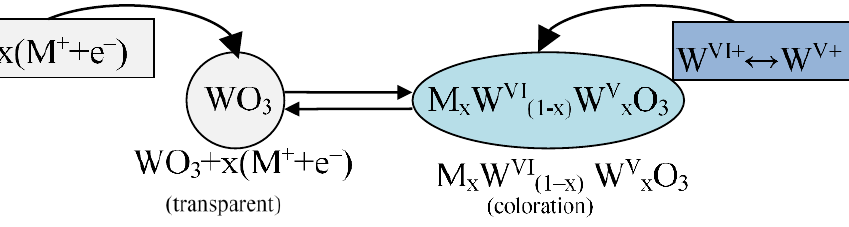
Figure 16. Electrochromic mechanism of WO 3 film. WO 3 films have different colors depending on x. At low values of x, the film is colored blue, and at high values of x, it has either a red or golden tint. These phenomena are associated with the fact that, firstly, WO 3 is partially reduced to the oxidation state V+, and secondly, the addition of the Li + cation occurs; all this leads to changes in the band gap and, as a consequence, in the light transmittance of the TMO.